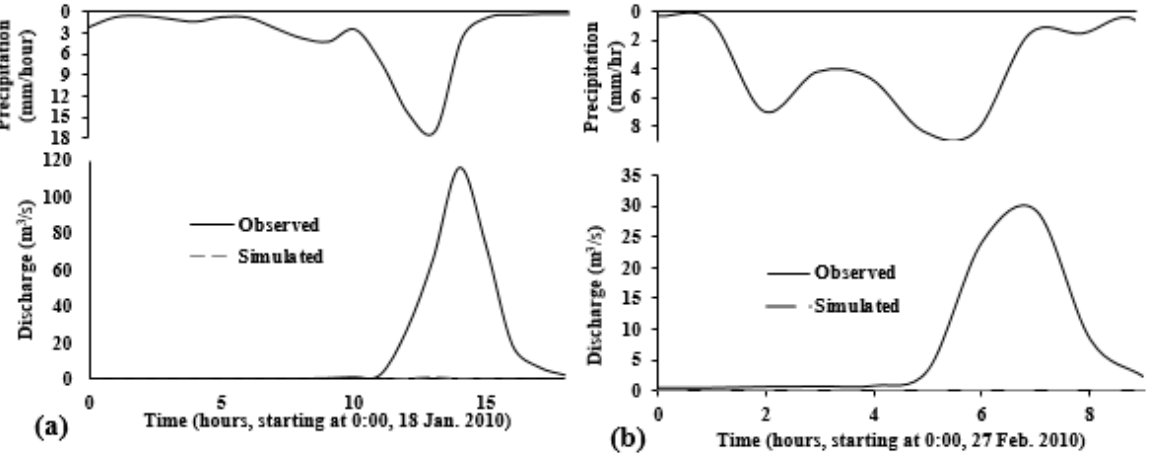
Figure 8. Upper Arroyo Seco pre-fire event calibrated model applied to post-fire events of ( a ) 18 January 2010 and ( b ) 27 February 2010.